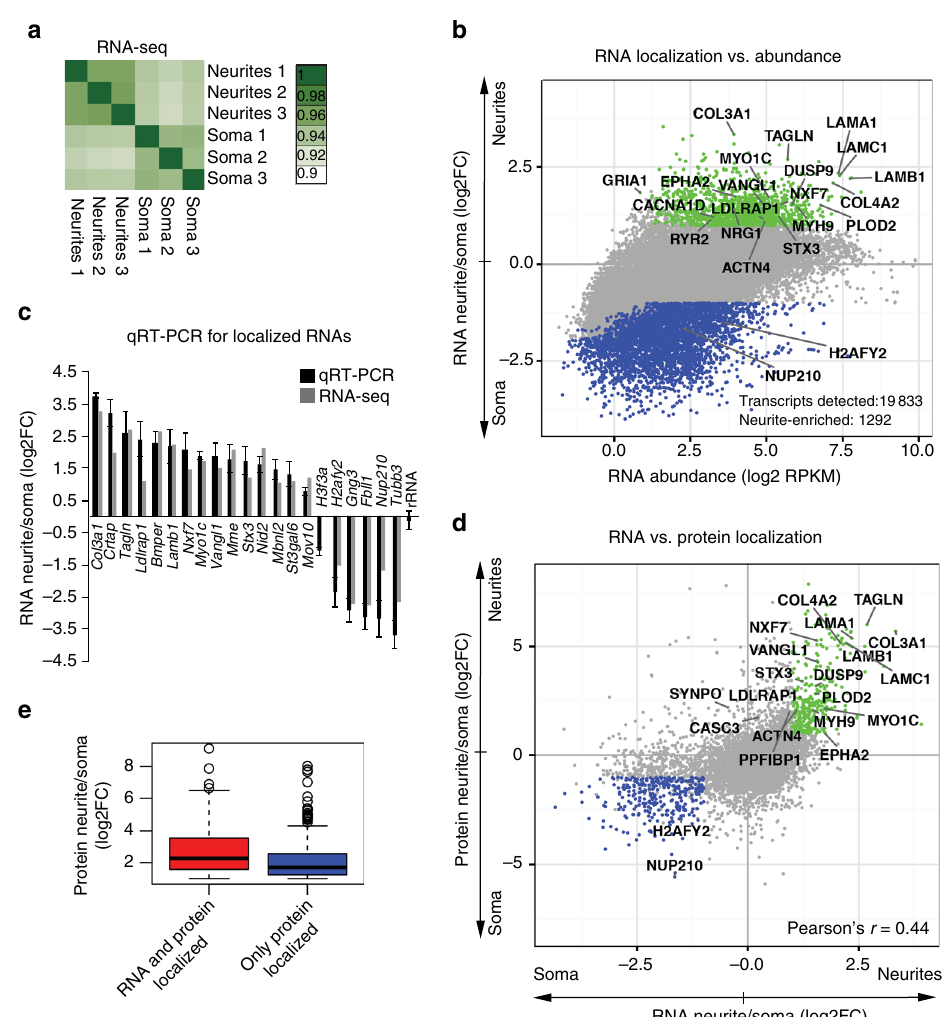
Fig. 2 RNA localization determines protein localization to neurites. a Correlation heatmap of individual RNA-seq libraries prepared from neurites and soma of iNeurons (three biological replicates). Numbers indicate Pearson ’ s correlation coef fi cients. b Local transcriptome from neurites and soma. RNA-seq data are presented as RPKM (reads per kilobase of transcript per million mapped reads) and shown as in Fig. 1d. c qRT-PCR for selected neurite-localized RNAs identi fi ed by RNA-seq. Histone RNAs and rRNA used as soma-localized and unlocalized controls. Error bars represent SD. d RNA and protein enrichement in neurites of iNeurons. Green : neurite-localized proteins and RNAs (log2FC > 1, P -values < 0.05); blue : soma-localized proteins and RNAs (log2FC < − 1, P -values < 0.05). e Average protein enrichment in neurites plotted for the group of genes localized at both protein and RNA level ( red ) and genes that are localized only at the protein level ( blue ; log2FC > 1, P -values <